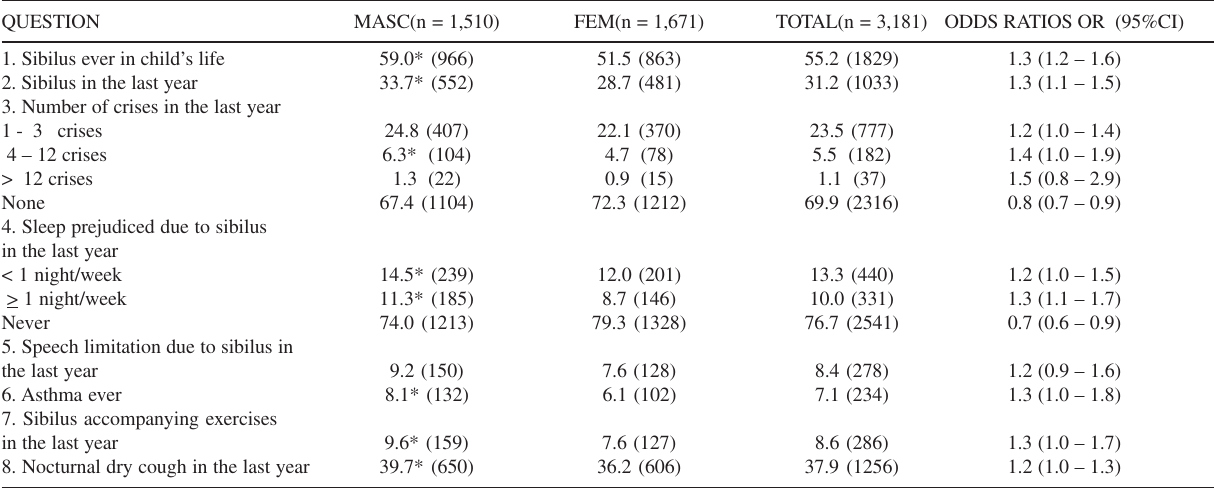
Table 1. Prevalence of asthma (%) symptoms, according to gender, in 3,312 6-7 year-old students from the western districts of São Paulo City